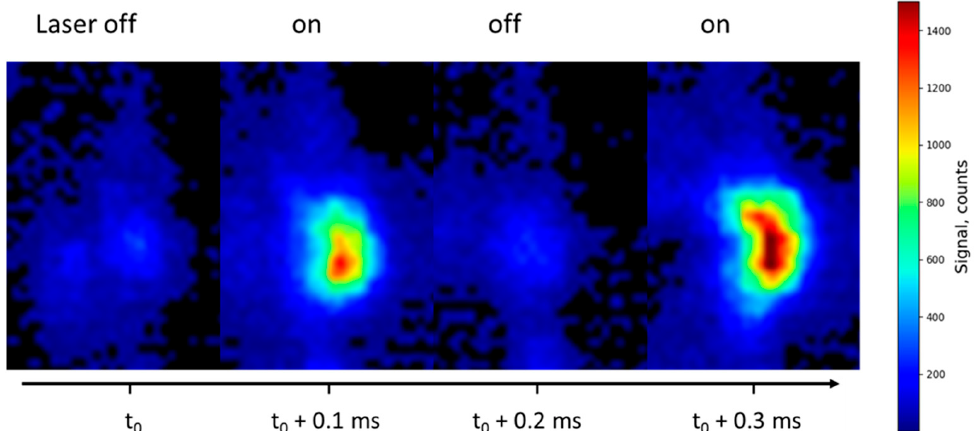
Figure 3. Alternation of instantaneous images, with laser switched off/on, recorded during the combustion of an Al/AP/HTPB solid-propellant sample at 1.5 MPa. One frame over two shows the contribution of the emission background. Sequence duration is 400 µs. The bean-shaped LIF island is isolated from the right-hand side of the flame, probably resulting from agglomeration. The dynamic of the signal is 0–1500 counts.